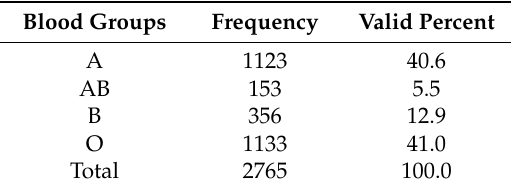
Table 1. The distribution of blood groups.